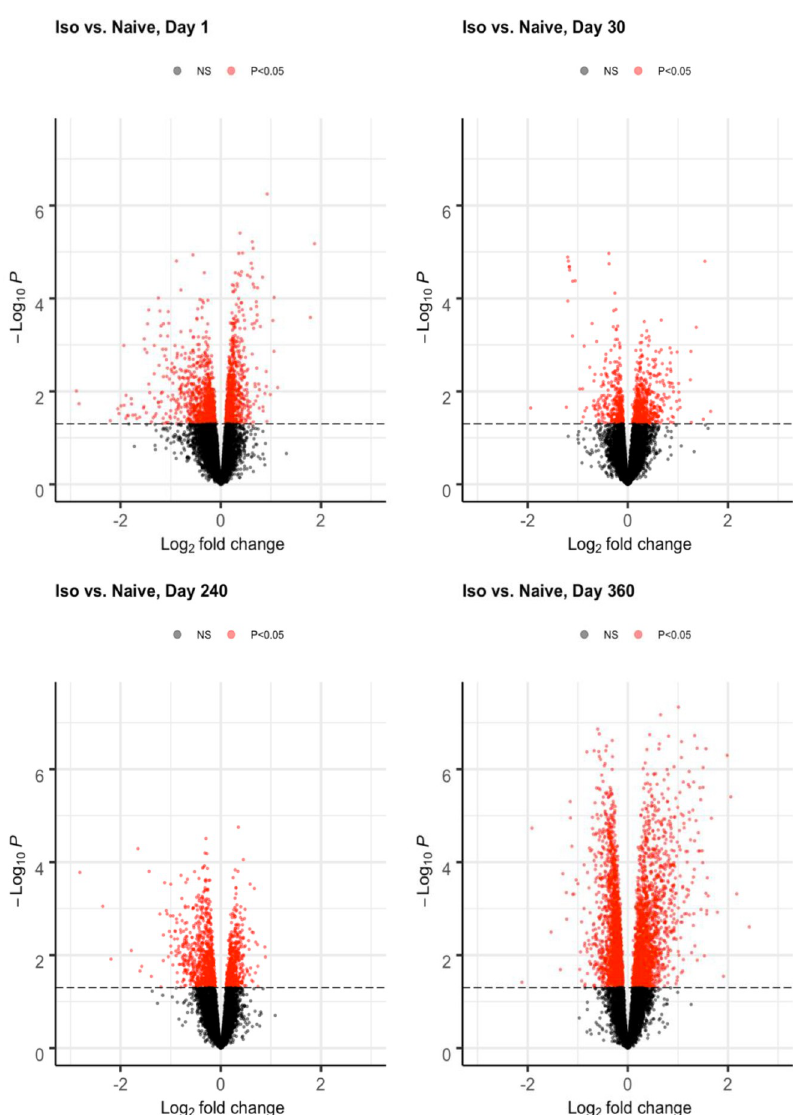
Fig 2. Volcano plots of differential expression analysis (ISO vs. Na ï ve) at each timepoint. The volcano plots were generated by pooling differential gene expression analysis results from each group (ISO vs na ï ve) at each post-exposure timepoint (Days 1, 30, 240, 360). Groups of rats exposed to air (na ï ve, n = 6/each timepoint group) or ISO (n = 5/Day 1 group, and n = 6/Day 30, 240, and 360 groups) were used. The volcano plot presents the nominal p-value against fold- change after log transformation for every gene represented by each dot. Red dots indicate differentially-expressed genes (DEG) with p-value < 0.05; black dots indicate non-significant (NS) genes.